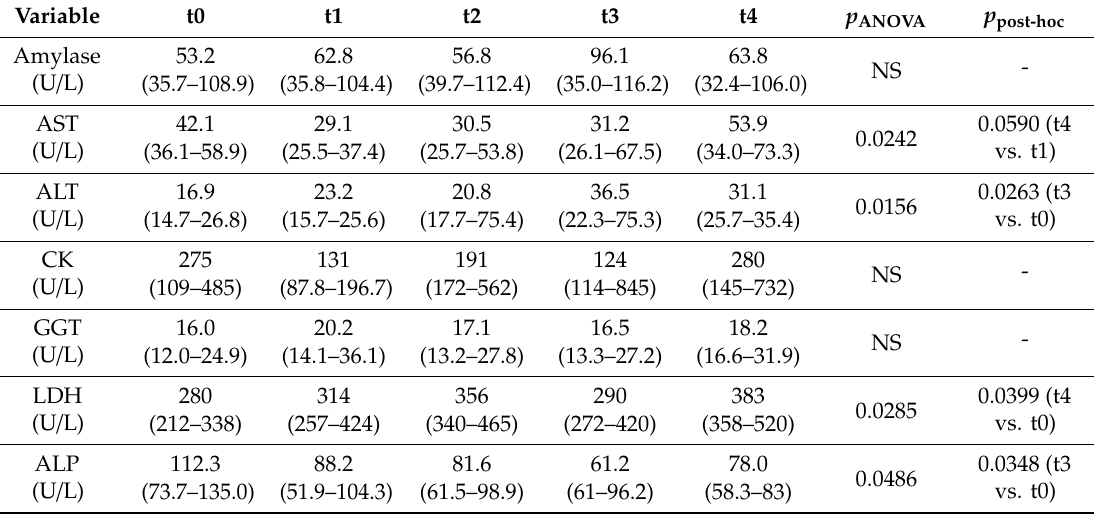
Table 3. Activities of participants’ selected plasma enzymes during the training macrocycle.